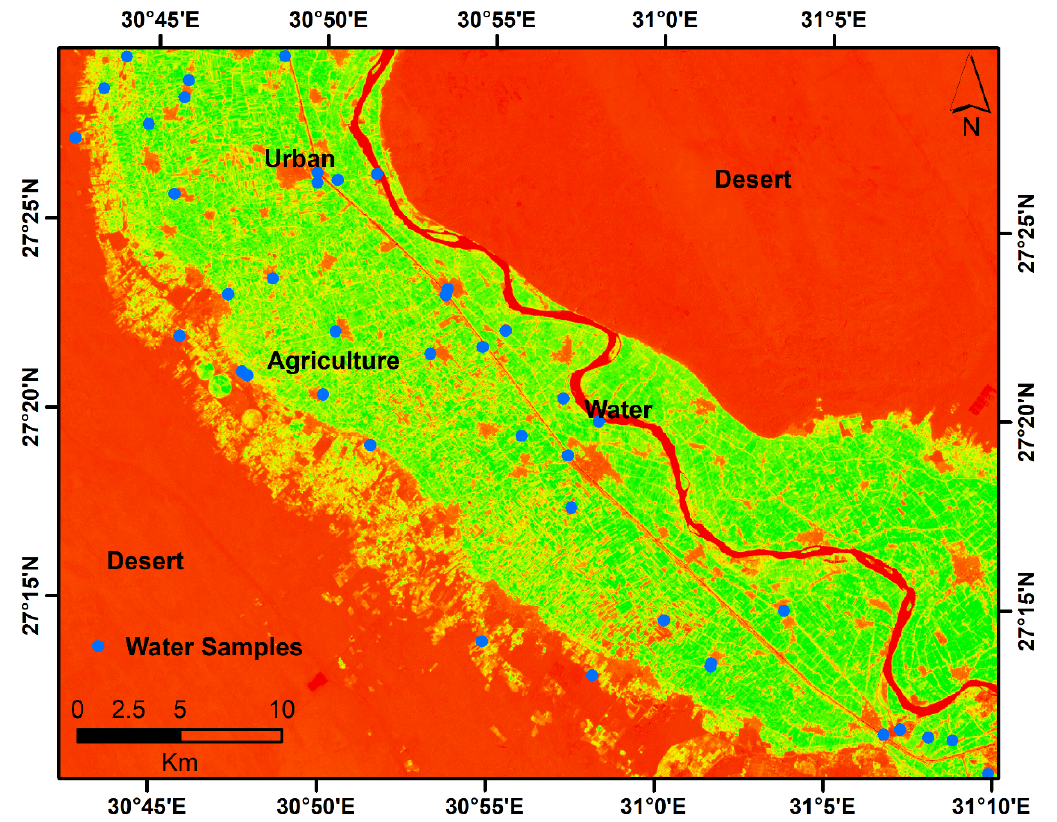
Figure 3. Land-use classi fi cation of the study area.